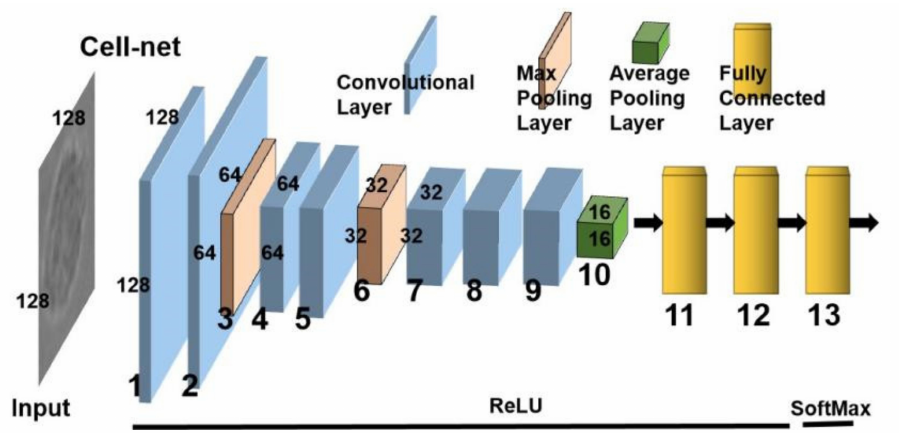
Figure 4. The structure of the